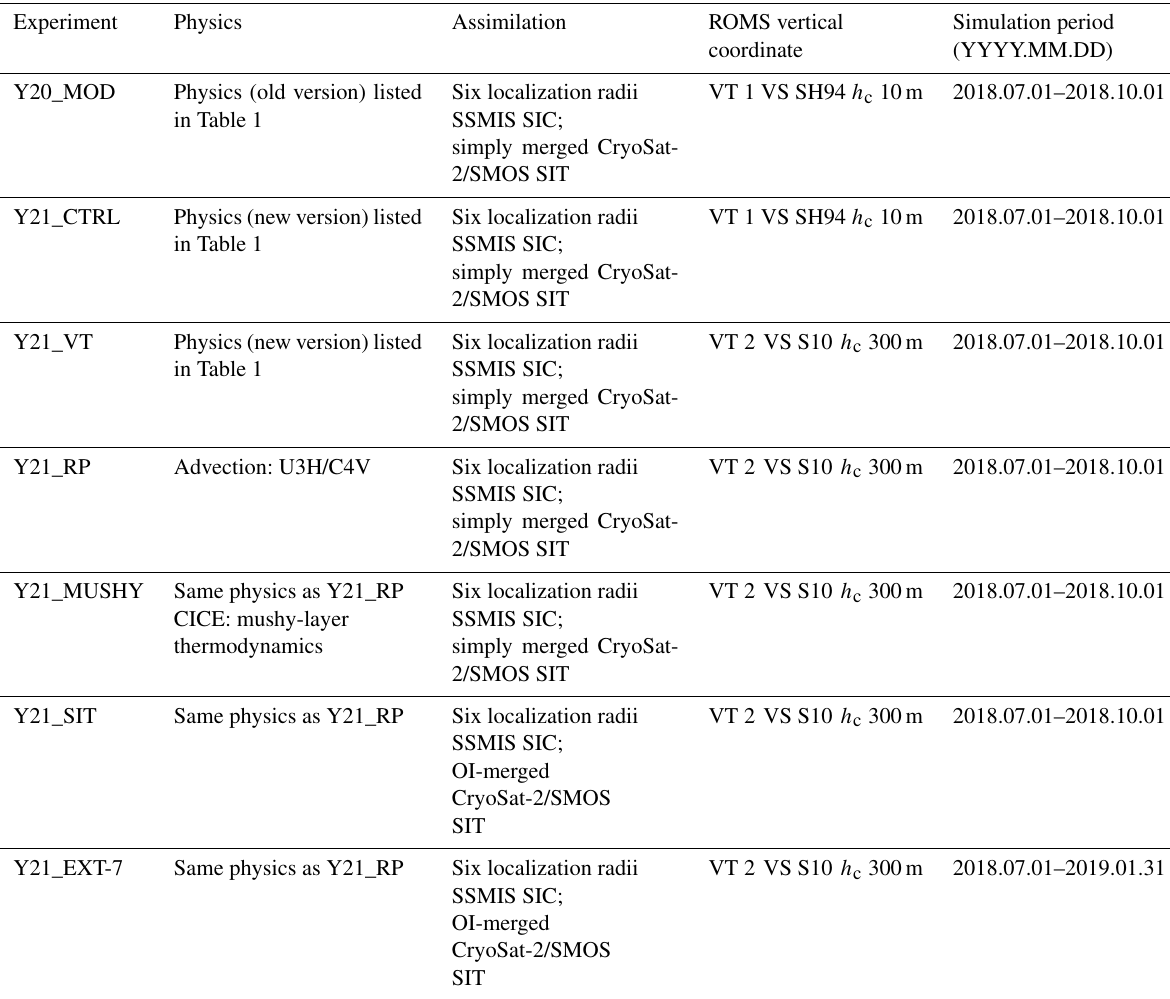
Table 2. The summary of the prediction experiments and details of experiment designs. Note that all experiments use the CFS operational forecasts as initial and boundary conditions. VT: vertical transformation function; VS: vertical stretching function; SH94: stretching function of Song and Haidvogel (1994); S10: stretching function of Shchepetkin